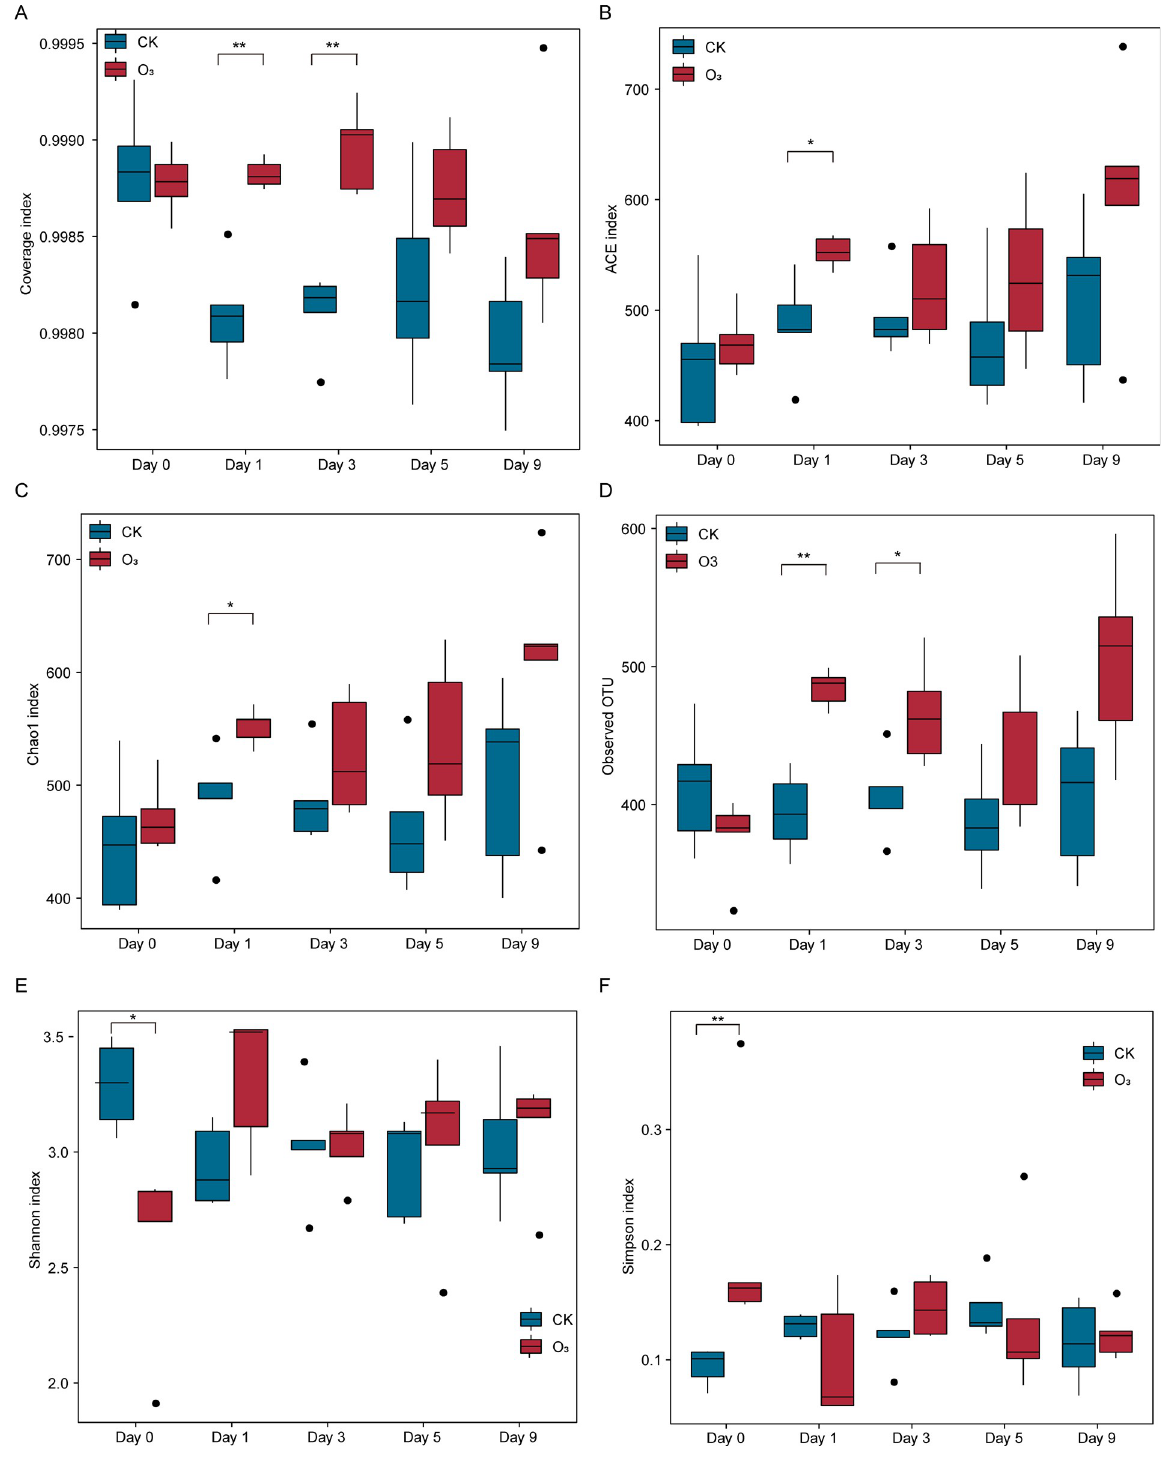
Fig 1. Microbial community diversity index of the CK group and O 3 group, respectively. (A) Coverage index (B) ACE index (C) Chao1 index (D) Observed OTU (E) Shannon index (F) Simpson index. CK: Control group; O 3: The OW disinfestation treatment group. Statistical significance: � p < 0.05, �� p < 0.01, ��� p < 0.001, ���� p < 0.0001.